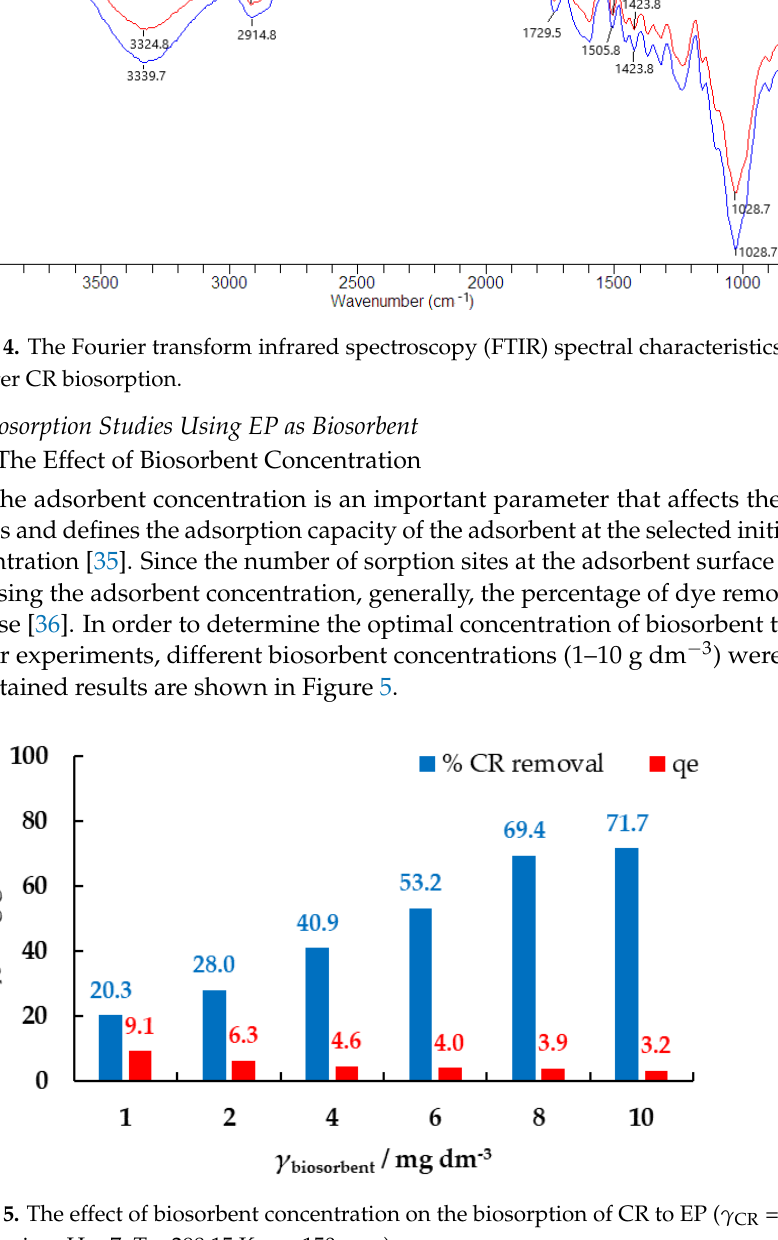
Figure 3. Field emission scanning electron microscopy (FE-SEM) micrographs of Euroamerican poplar (EP) at different magnifications: ( a ) 500, ( b ) 1000, ( c ) 2000, ( d ) 5000.